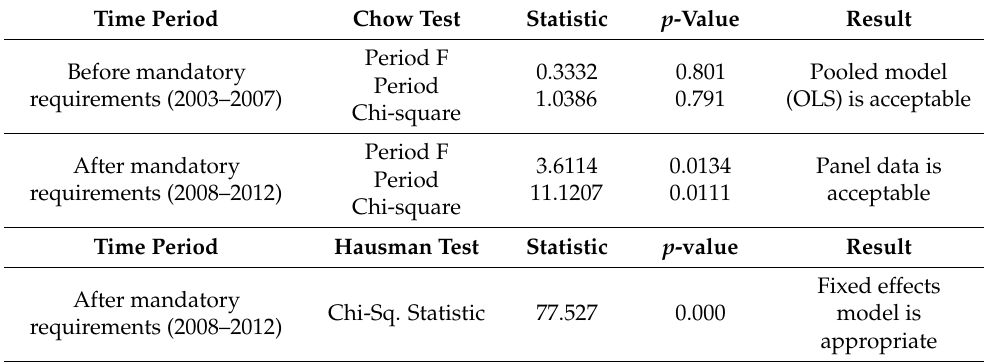
Table 4. F-limer and Hausman tests.